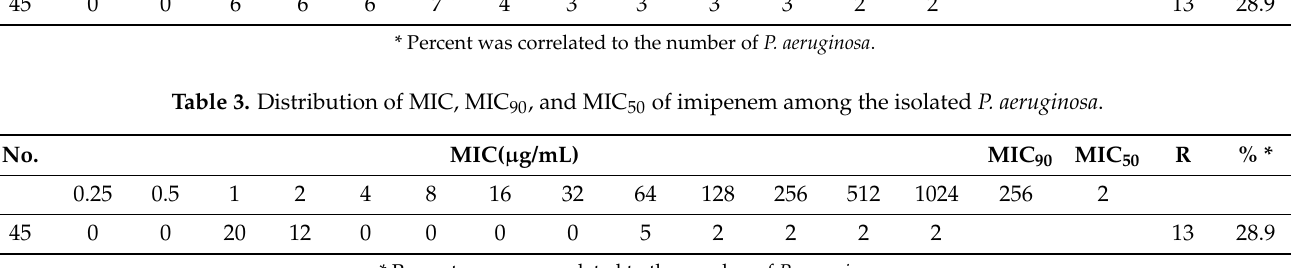
* Percentage was correlated to the number of P. aeruginosa.